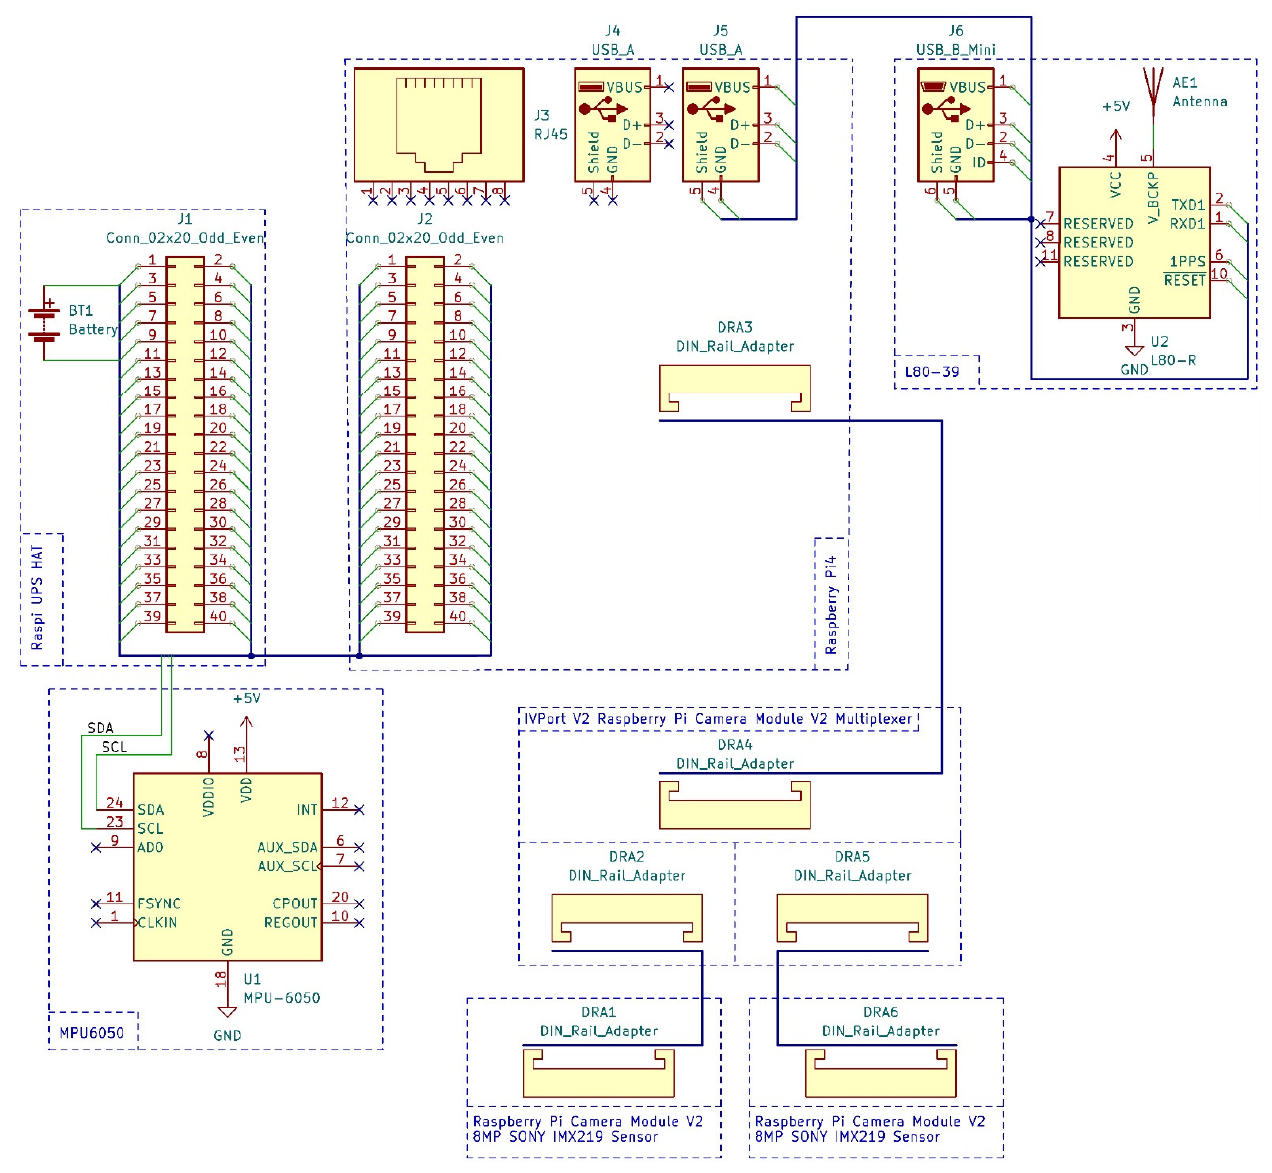
Figure 1. Connection diagram for Raspberry Pi4 modules and expansion boards.